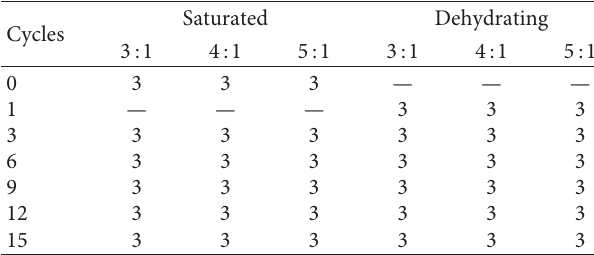
Figure 2: Specimen curing. Table 2: Number and classification of